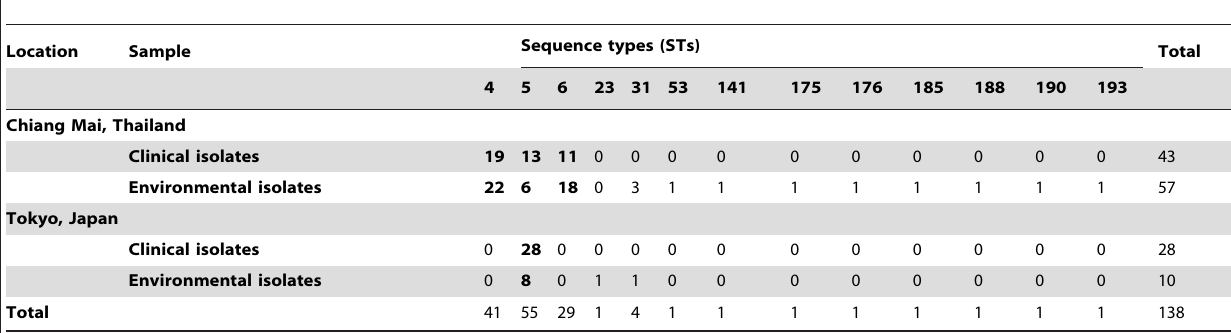
Table 5. Distribution of sequence types (STs) of C . neoformans isolates from clinical and environmental samples from Thailand and